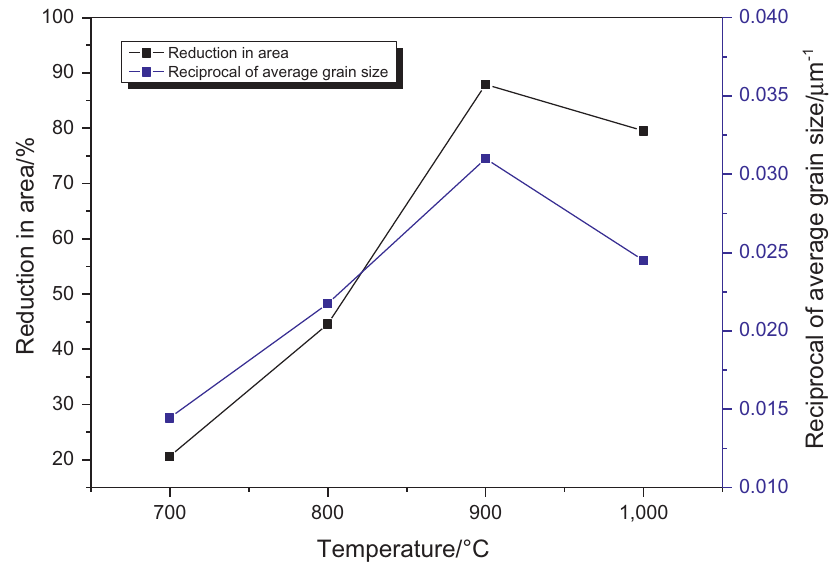
Figure 8: Variations of reduction in area and reciprocal of average grain size with temperature.